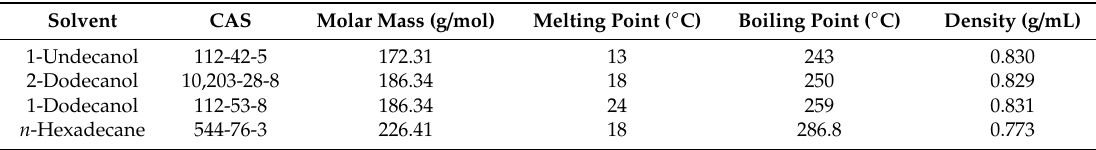
Table 2. Solvents tested for target compounds extraction by